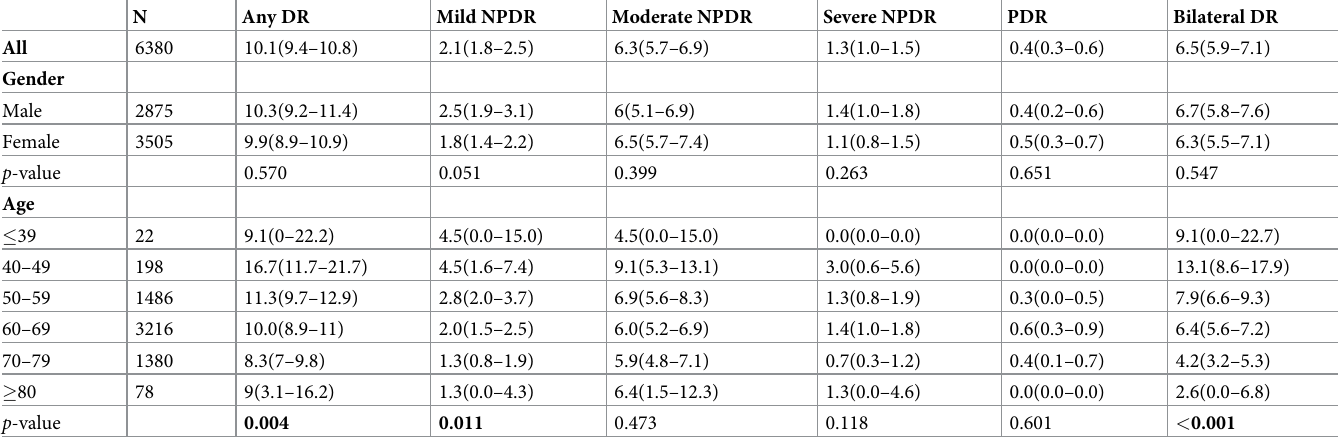
Table 3. Age-and gender-specific prevalence (95% CI) of DR in study subjects.